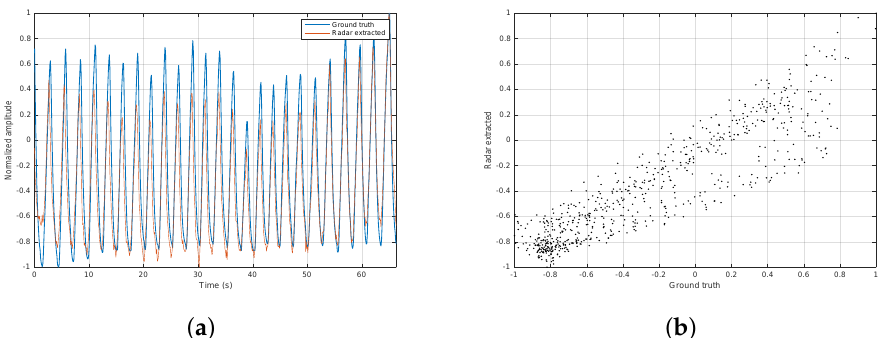
Figure 8. Experiment 2 signal extraction. ( a ) ground truth and radar extracted on top of each other. ( b ) correlation scatter.